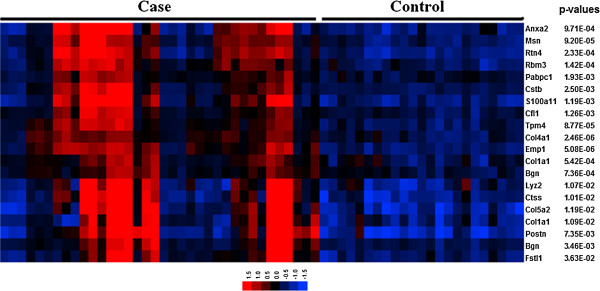
Gene expression patterns of top candidate community. Expression values are color-coded: from low (blue) to high (red), and levels of differential expression are shown as adjusted P values.